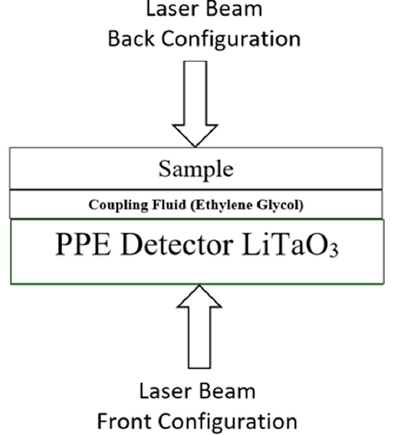
Figure 2. Front and back PPE detection configurations.